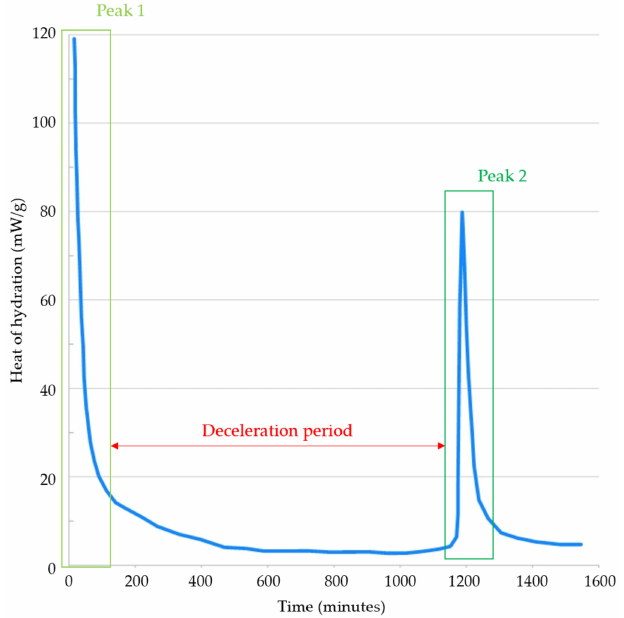
Figure 5. Rate of hydration of tricalcium aluminate with 45% sulfates by mass of tricalcium aluminate (modified from